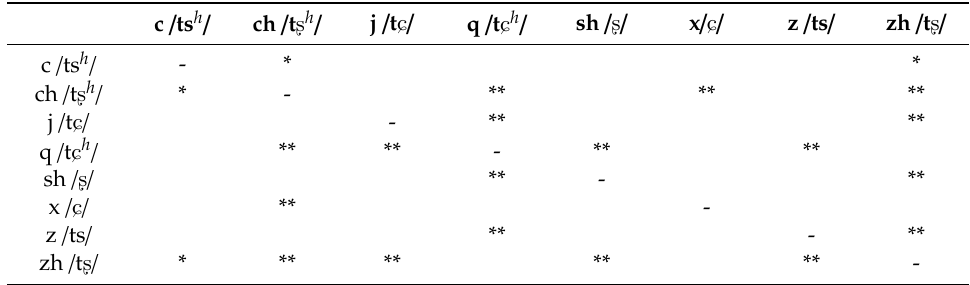
Table 3. Pairwise comparisons of di ff erences between the consonants in perception (** p < 0.01, * p <